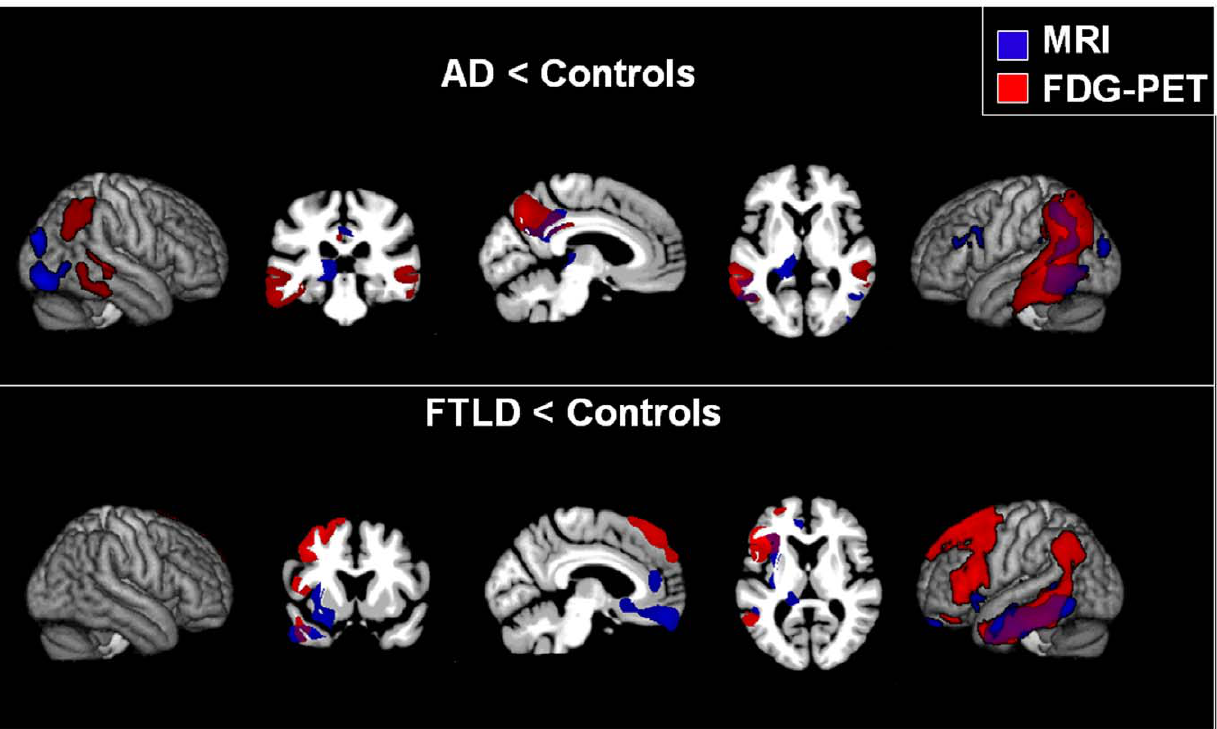
Figure 1. Group differences. Differences between AD patients and controls (upper part) as well as FTLD patients versus controls (lower part) in brain glucose utilization (FDG-PET, red) and atrophy (MRI, blue). Areas of overlap are shown in violet. Only clusters are shown that exceeded a significance threshold of p , 0.001 uncorrected at voxel level and a cluster threshold of 2000 voxels. Left is left.